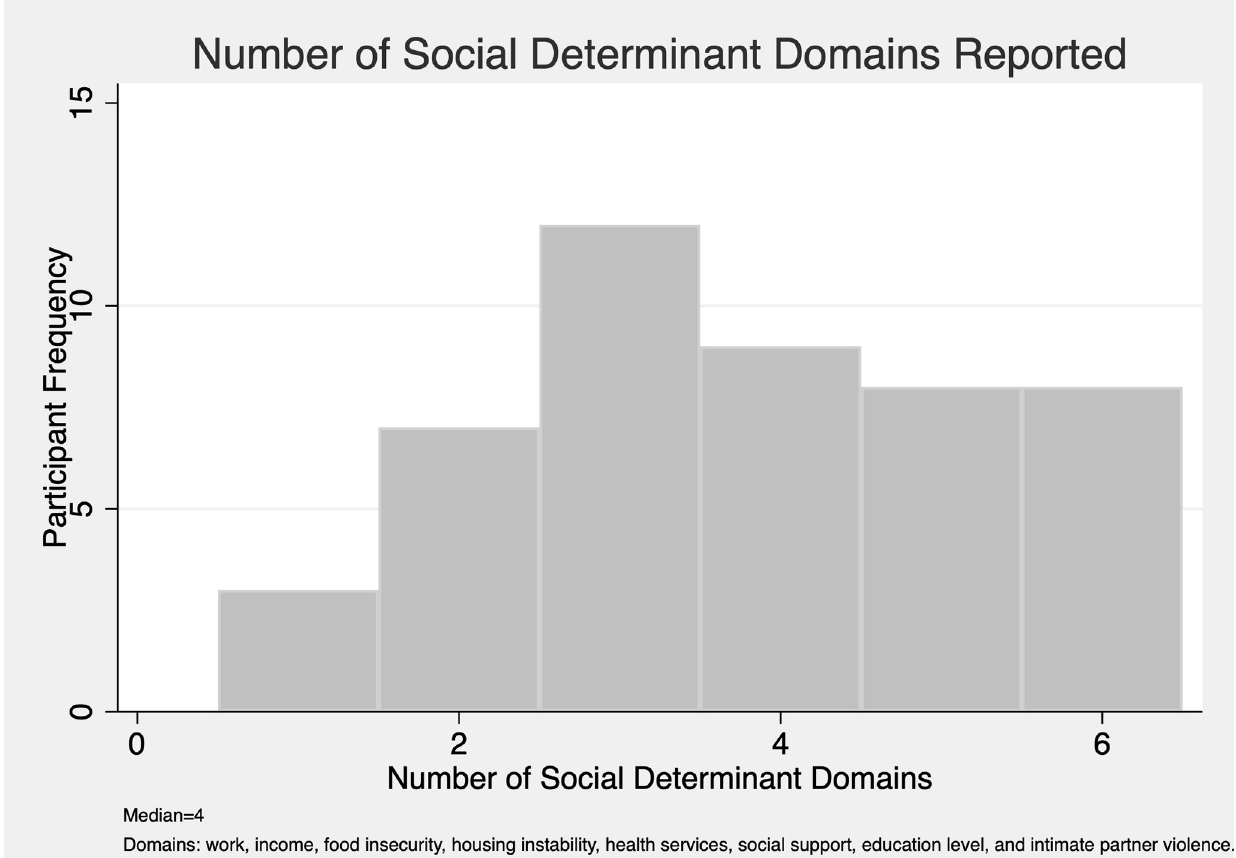
Fig 1. Social determinant domain frequencies (n =